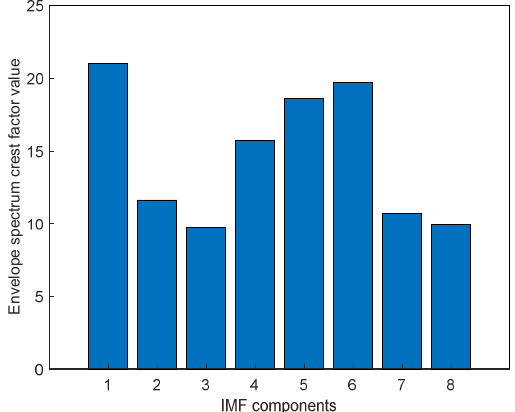
fitness function value changing with the number of iterations is shown in Figure 26. Figure 25. Each component envelope spectrum crest factor value. Figure 25. Each component envelope spectrum crest factor value.